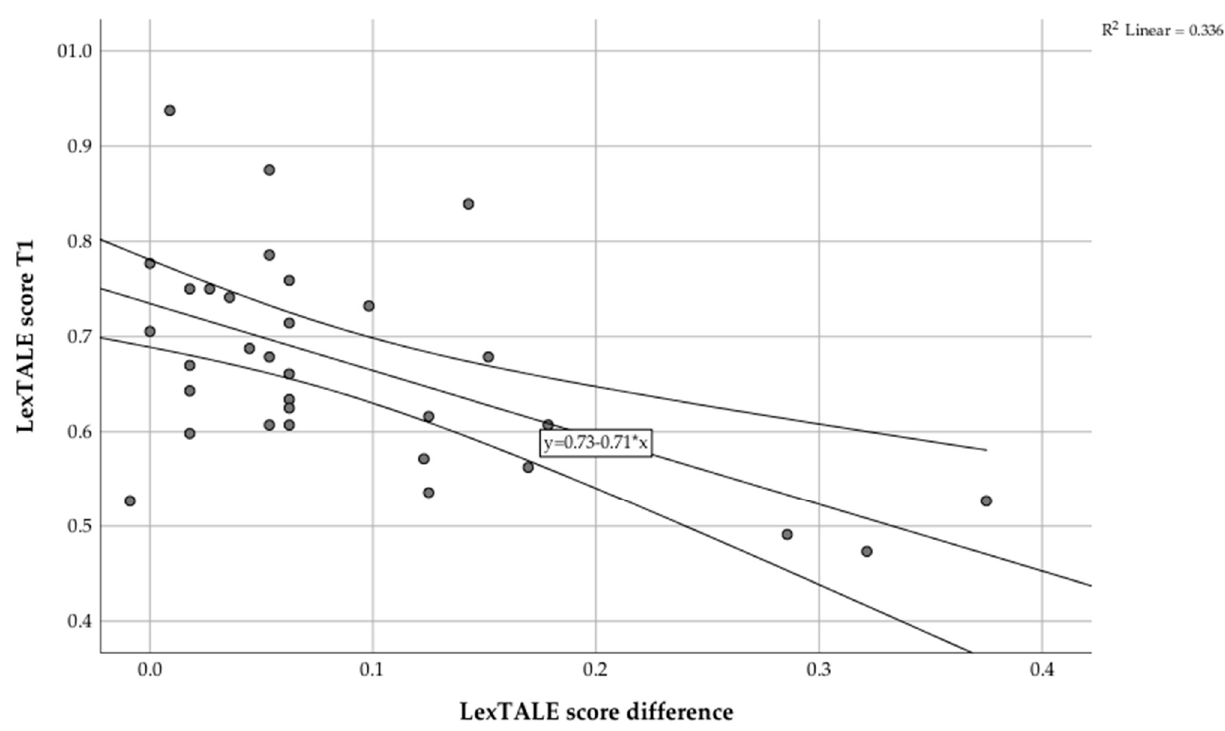
Figure 2. Changes in actual proficiency before and after the SA period, sorted according to the score at Time 1.